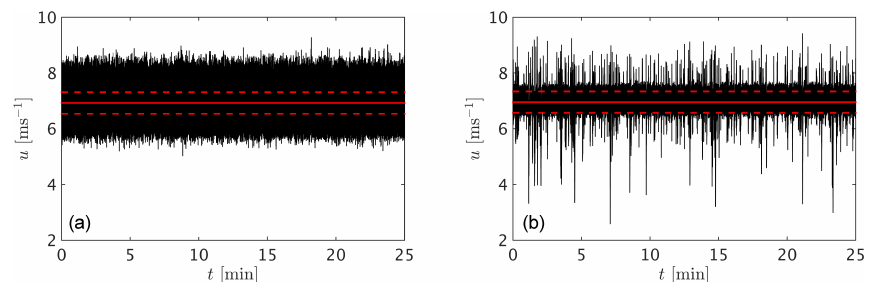
Figure 5. Velocity time series as defined in Eq. (9) of the two inflows considered, A (Gaussian, a ) and B (intermittent, b ). Further information is shown in Table 3. Solid red lines mark (cid:104) u ( t ) (cid:105) and dashed red lines indicate (cid:104) u ( t ) (cid:105)± σ u .